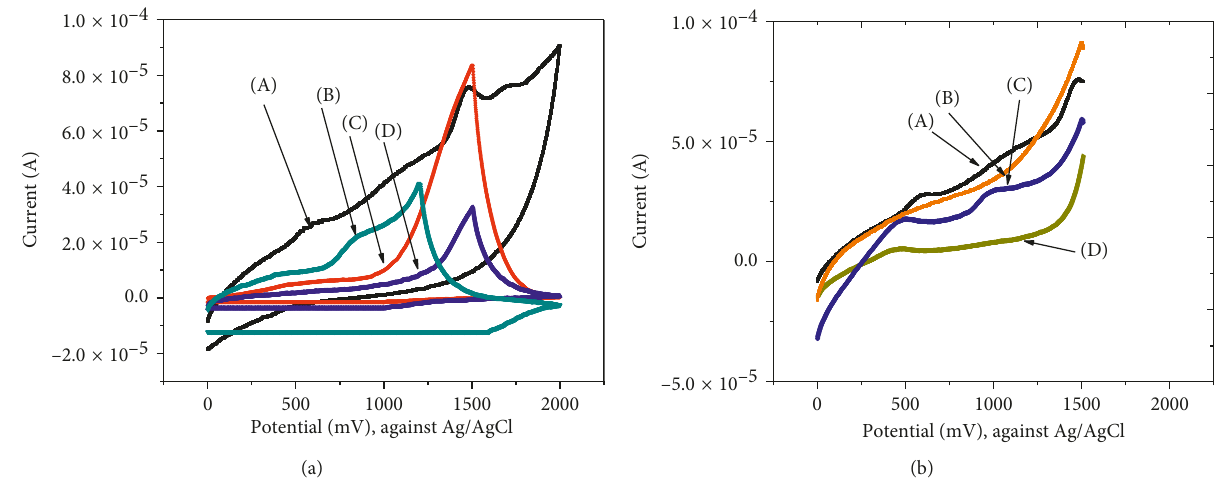
Figure 4: (a) Cyclic voltammogram of (A) AFB1 in 0.1M KNO 3 , (B) AFB1 incubated with citric acid for 60min at 28 ° C, (C) citric acid in 0.1M 12). (b) Cyclic voltammogram of (A) AFB1 in methanol, (B) garlic extract in KNO 3 , and (D) PBS (scan rate of 50mV/s; phosphate buffer pH (cid:30) 0.1MKNO 3 , (C)AFB1 incubatedwithgarlicextract for60min at28 ° C,and (D)phosphate buffer(scanrate of50mV/s;phosphatebufferpH Table 1: Comparison between different reported plant extracts for detoxification of aflatoxin with current work.